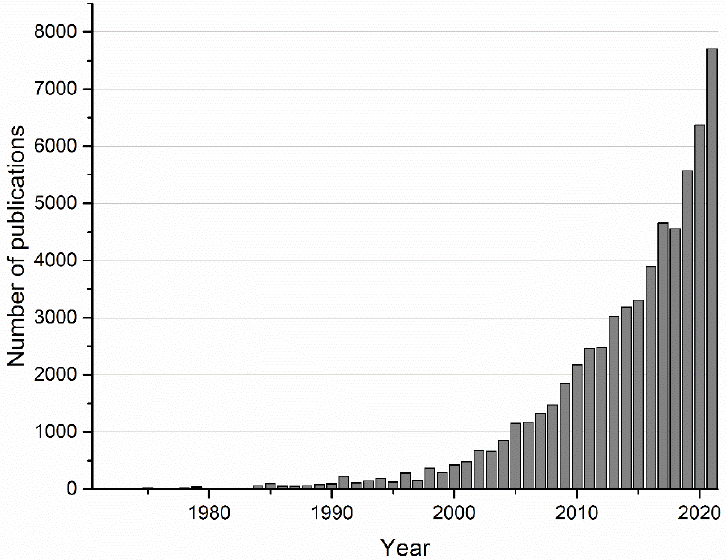
Figure 1. Number of publications related to biomaterials and biocompatibility from 1970 to 2021 based on the Science Direct search database.